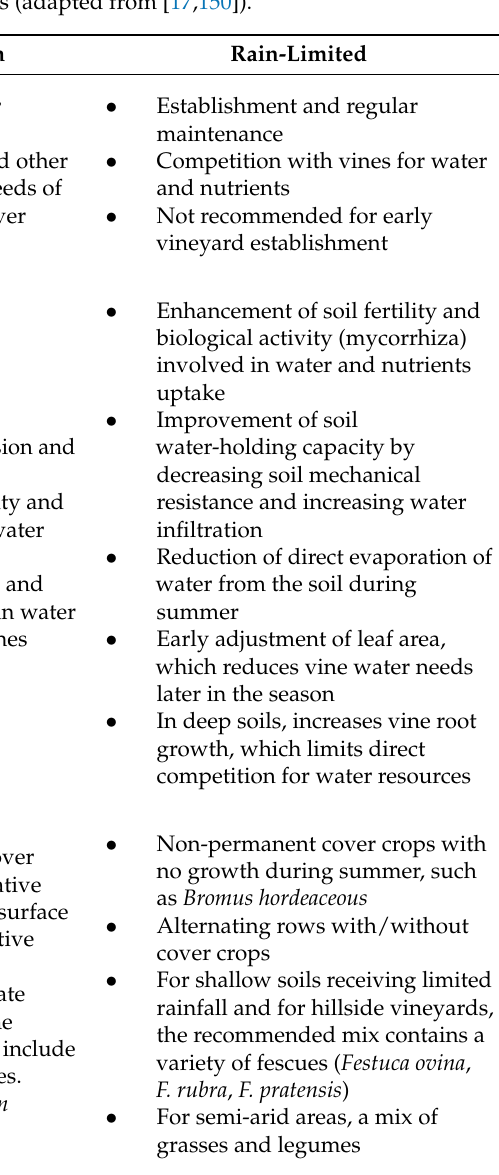
Table 2. Costs and benefits of cover crops for vineyard floor management under climates without water stress and climates with summer droughts (adapted from